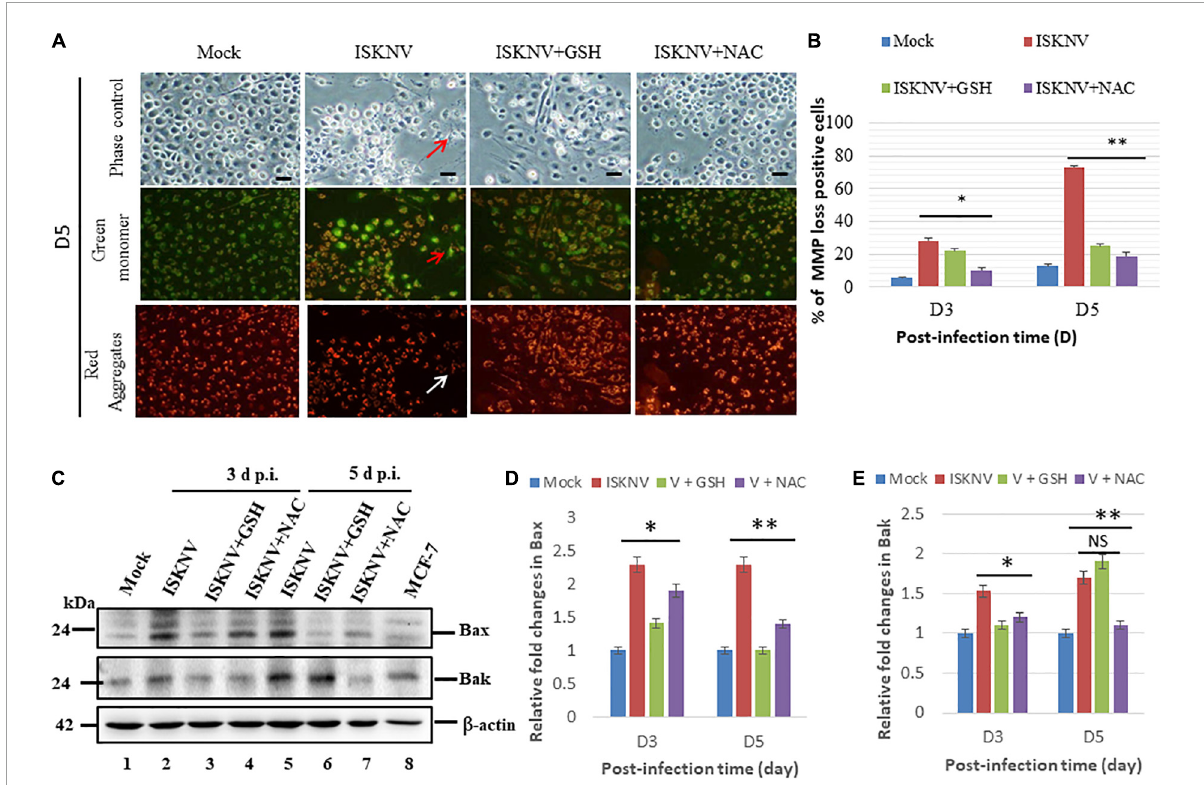
FIGURE5 Glutathione (GSH) and N -acetylcysteine (NAC) can reduce infectious spleen and kidney necrosis virus (ISKNV)-induced mitochondrion-mediated Bax/Bak death signals in fish cells. (A) Identification of antioxidant-blocked ISKNV-induced MMP loss in fish cells at day 3 and day 5 post-infection. Phase contrast images for mock control group, ISKNV, GSH plus ISKNV, and NAC plus ISKNV (upper panels); green fluorescence images (middle panels) for MMP loss-positive cells; and red fluorescence images (lower panels) for MMP loss-positive cells, in which MMP loss-positive cells are indicated by arrows. Scale = 10 µ m. (B) The ISKNV-induced losses of MMP in fish cells were counted at day 3 and day 5 post-infection. The quantification of these results was performed for three individual experiments. All data were analyzed using either paired or unpaired Student’s t -tests, as appropriate. ∗ P < 0.01. (C) Identification of pro-apoptotic Bax and Bak proteins using western blot analysis. ISKNV-infected fish cells treated with GSH (2 mM) and NAC (2 mM) at day 0 (mock control), day 3, and day 5, where lanes 1–7